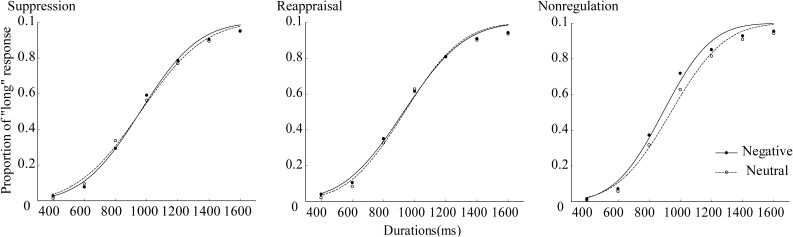
Proportion of “long” response plotted as a function of stimulus duration for suppression, reappraisal, and nonregulation groups.